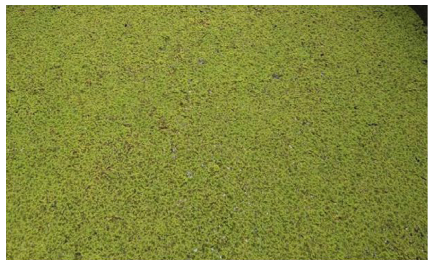
Figure 1: Picture of Azolla pinnata plant from the